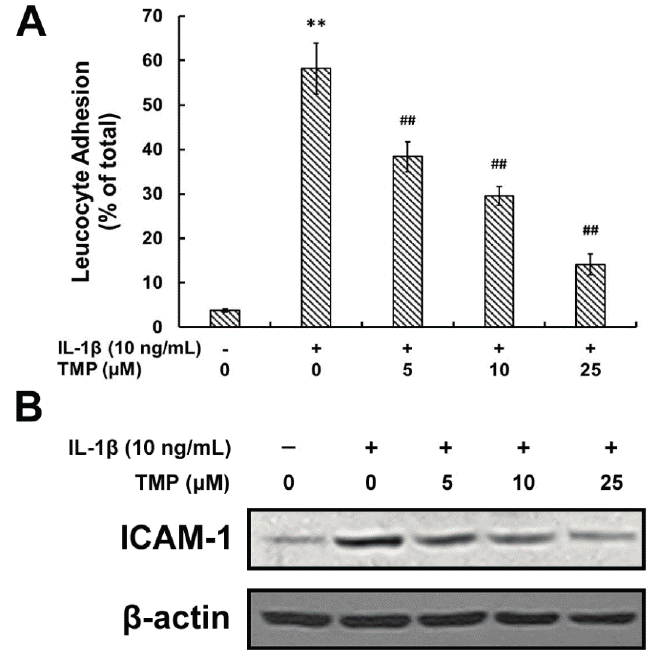
Figure 3. Effect of TMP on IL-1 β -induced leukostasis and ICAM-1 expression in TR-iBRB2 cells. After treatment of indicated drugs, leukocyte adhesion to TR-iBRB2